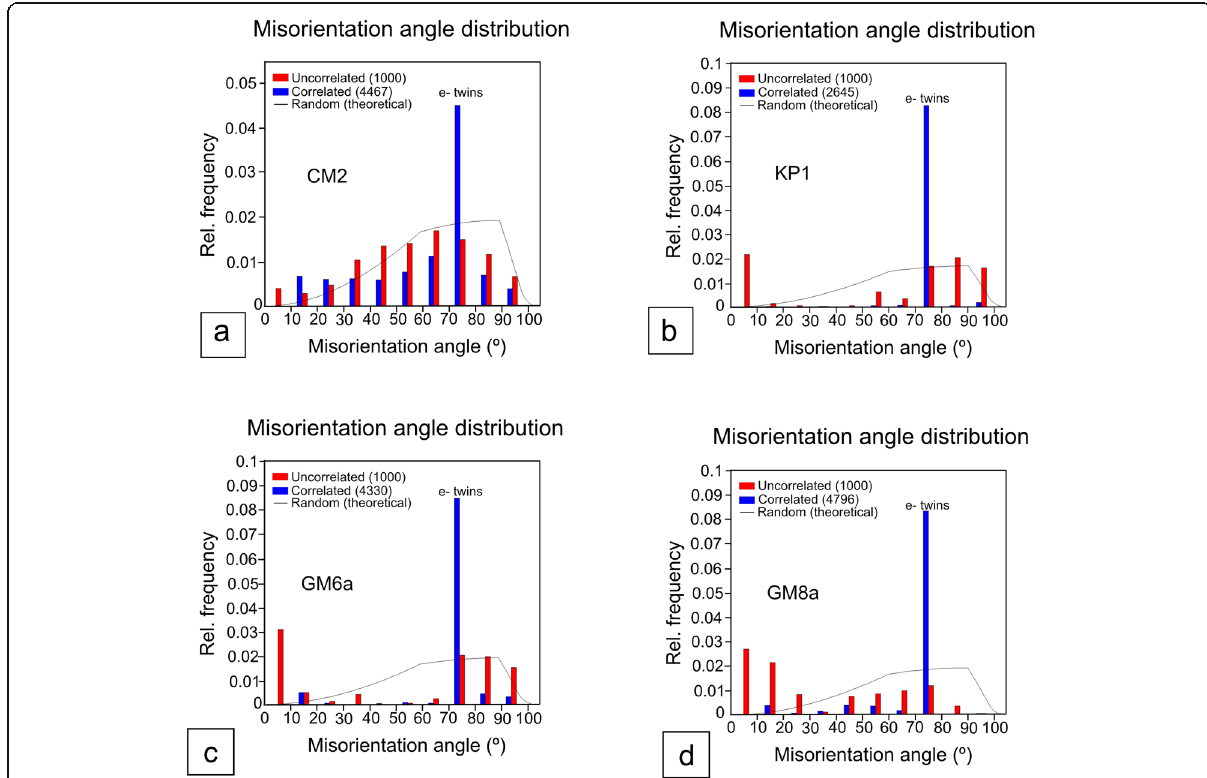
Fig. 4 Misorientation angle distribution plot of representative samples. Both neighbor-pair/correlated (blue) and random-pair/uncorrelated (red) are plotted. The theoretical distribution of misorientations (shown by line graph) for calcite is also plotted. a CM2. b KP1. c GM6a. d GM8a. The peaks of neighbor pair misorientation in both the plots suggest development of the